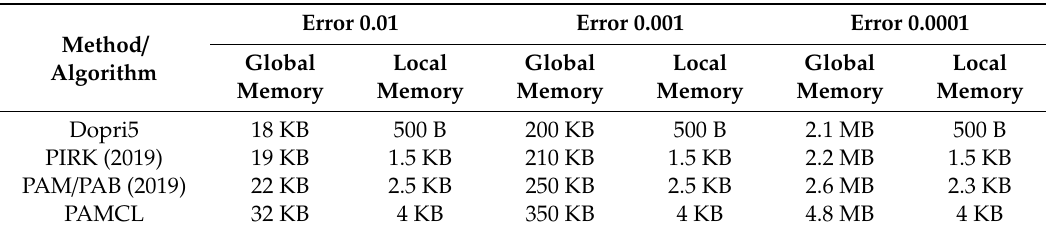
Table 4. Comparison of “memory usage” w.r.t the target error while involving different solver algorithms for solving the Rössler equation.